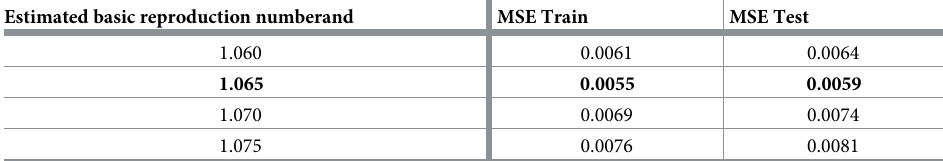
Table 8. The MSE value of ANN-PSO network after interval limiting [1,1.2] and obtaining the lowest error rate in estimating basic reproduction numberand. Estimated basic reproduction numberand MSE Train MSE Test 1.060